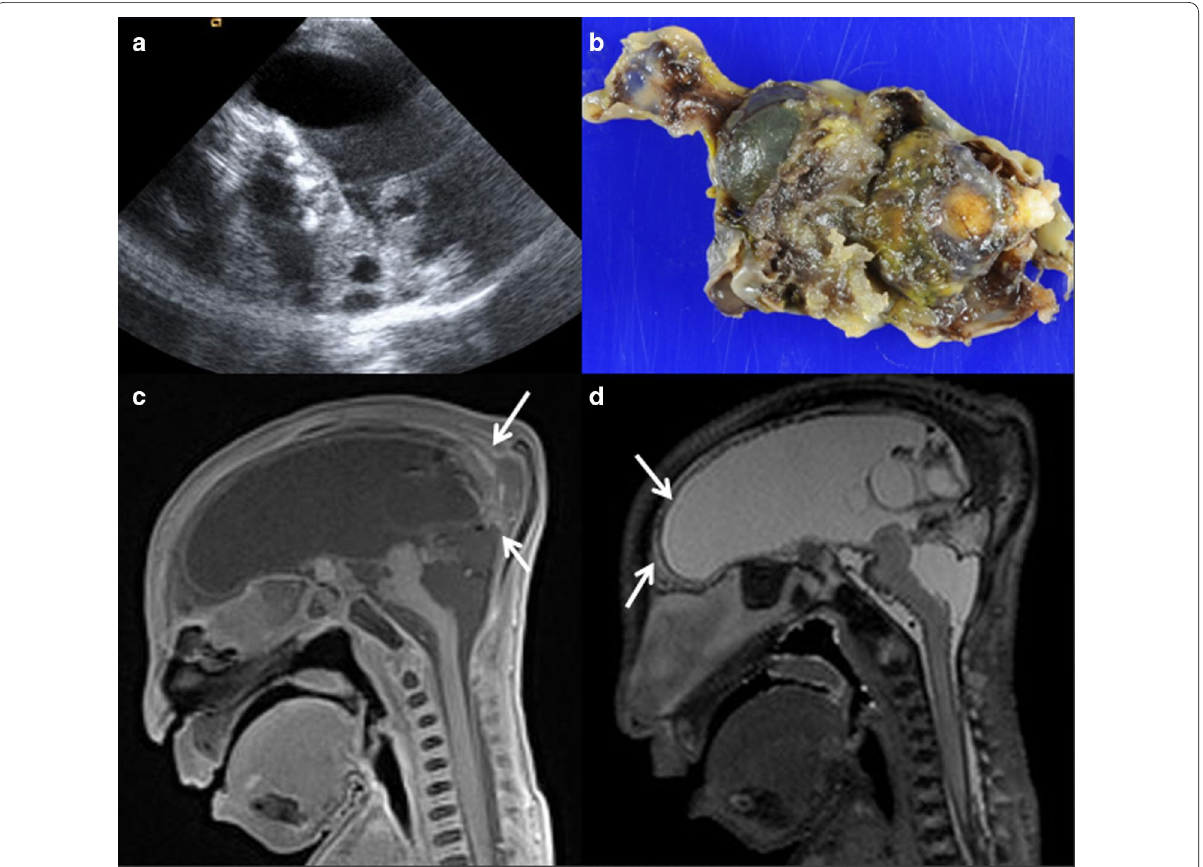
Fig. 11 Hydranencephaly in a 30‑week foetus. ( a ) Sagittal ultrasound. b Pathology specimen, microcephaly with cystic degeneration of the brain. c Sagittal T1W, ( d ) Sagittal T2W MRI showing brain parenchyma with residual cortical tissue